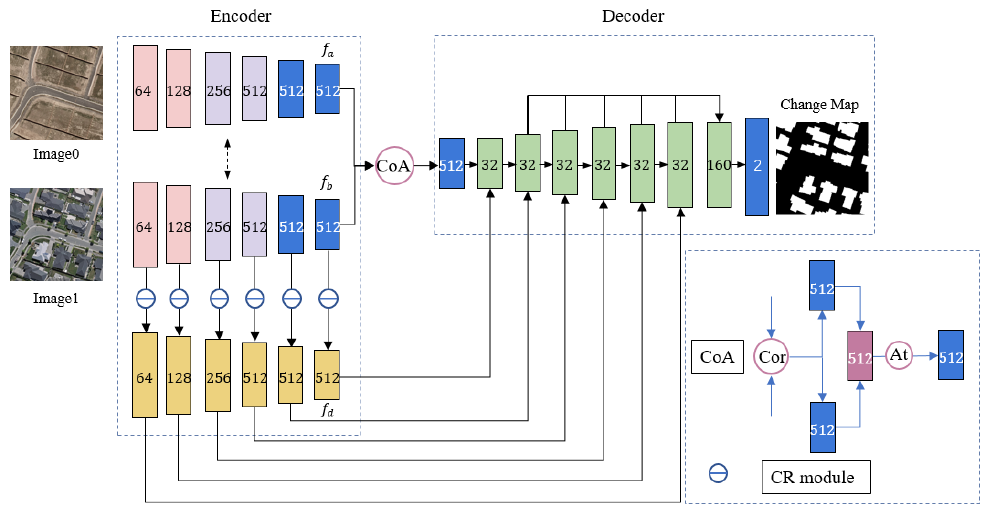
Figure 3. Overview of pyramid feature-based attention-guided Siamese network (PGA-SiamNet Network). CoA indicates the co-attention module.